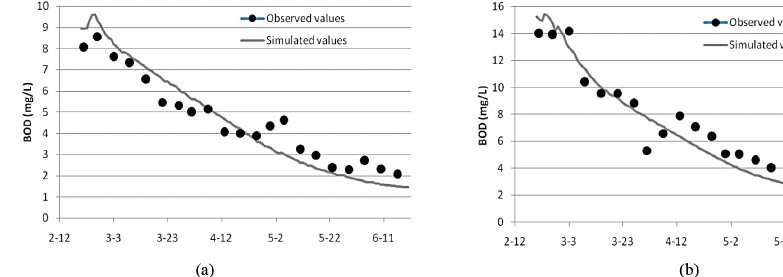
Figure 9. Calibration results for BOD at sites 12 (a) and 11 (b) .